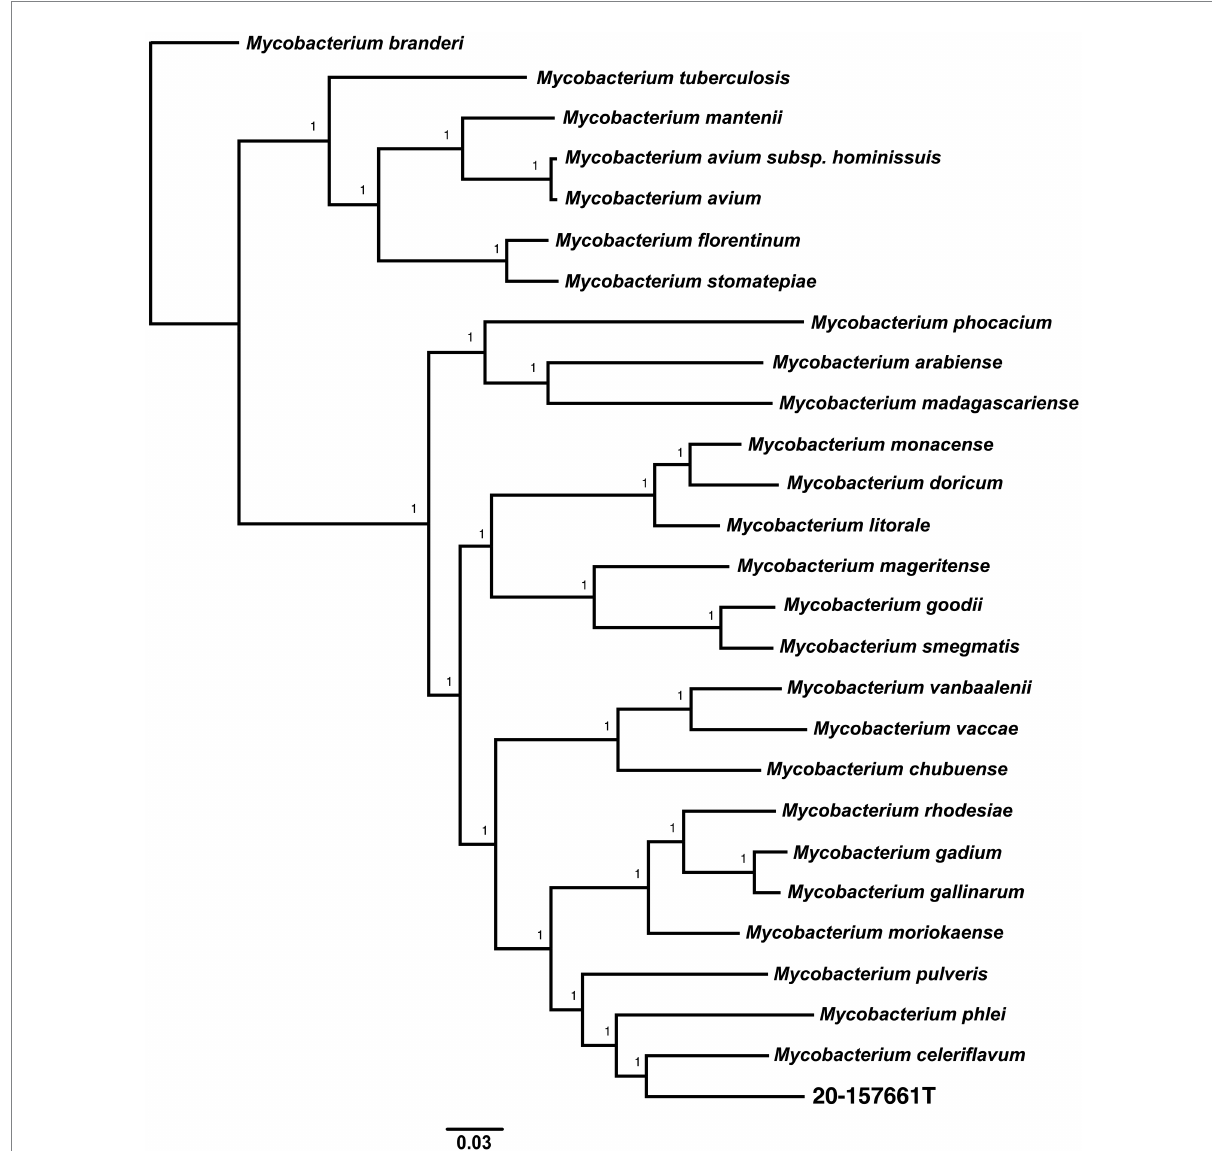
FIGURE 4 Unrooted core genome species tree calculated using 1,083 concatenated single copies orthologous protein sequences. The core genome alignment was generated using OrthoFinder v2.5.4 (Emms and Kelly, 2017, 2018, 2019) using default parameters. The scale bar represents the number of amino-acids substitutions per site. A Shimodaira-Hasegawa (SH) test was used to calculate the statistical support of the tree